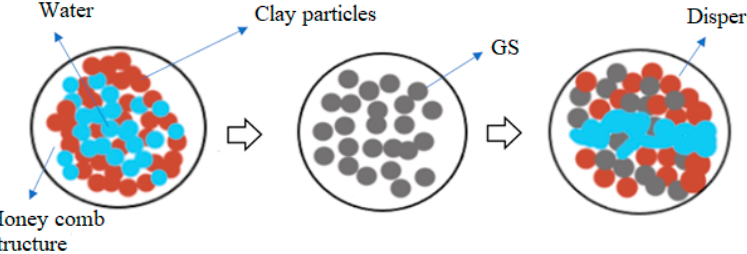
Figure 4. Change in soil structure with addition of GS at constant water content.